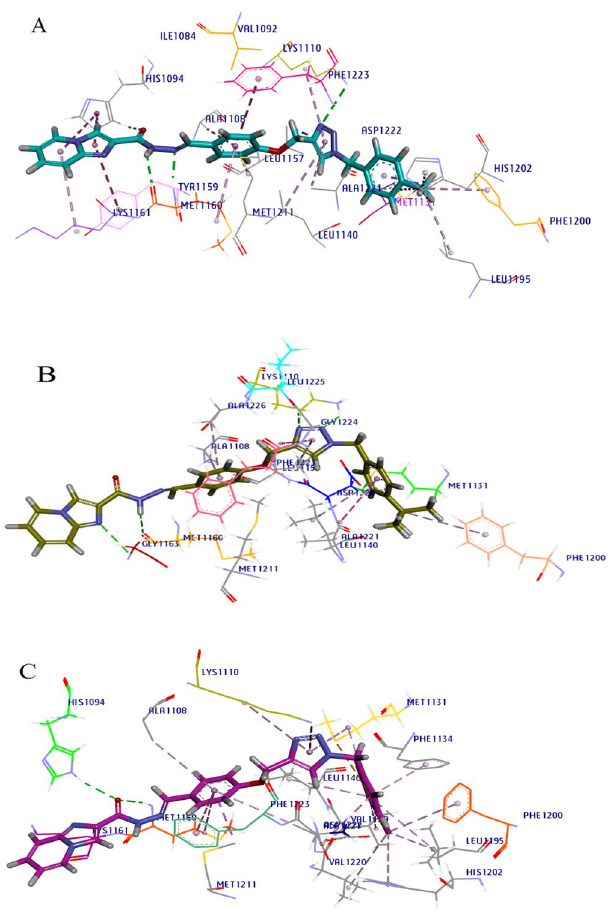
Figure 9. MD simulation analysis of selected compounds against c-Met. 3D MD interaction patterns of compounds 6d ( A ), 6e ( B ) and 6f ( C ) with the highest percent population in cluser1 inside the active site of c-Met kinase are shown. Van der Waals, hydrogen bonds, and pi–alkyl interactions were colored as light green, bold green and light pink, respectively. Furthermore, pi–anion, pi–sulfur and pi–pi interactions were colored as dark orange, light orange and dark pink, respectively. Images were created by Discovery Studio Client